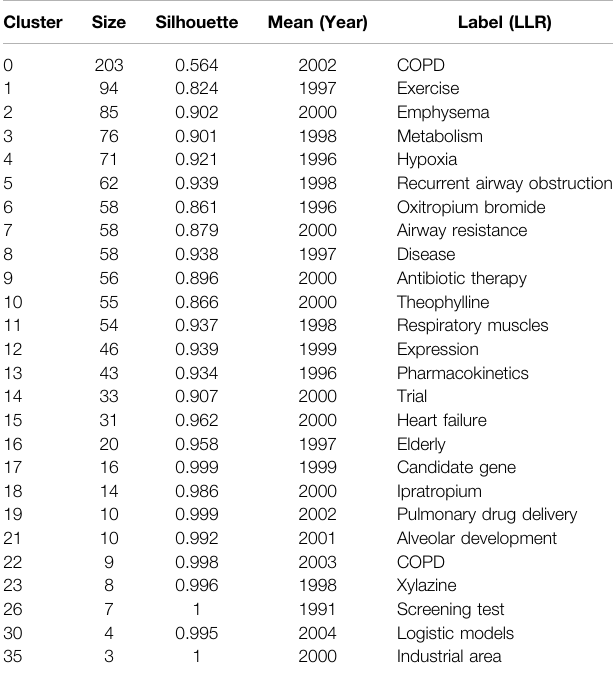
TABLE 7 | Clustering of keywords in COPD drugs-related studies that were published from 1980 to 2021. Cluster Size